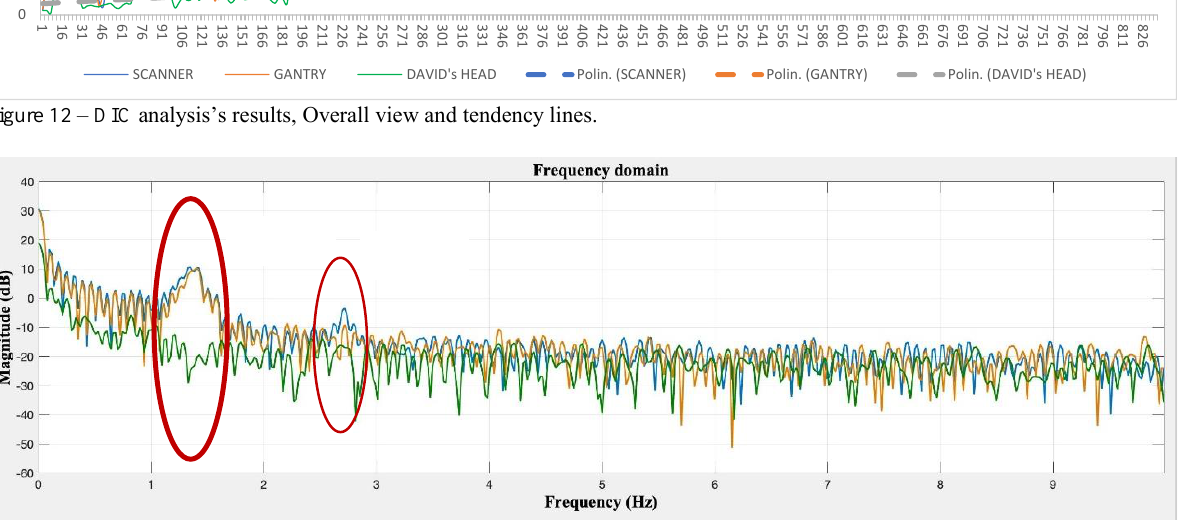
Figure 13 – DIC analysis’ results in the frequency domain.